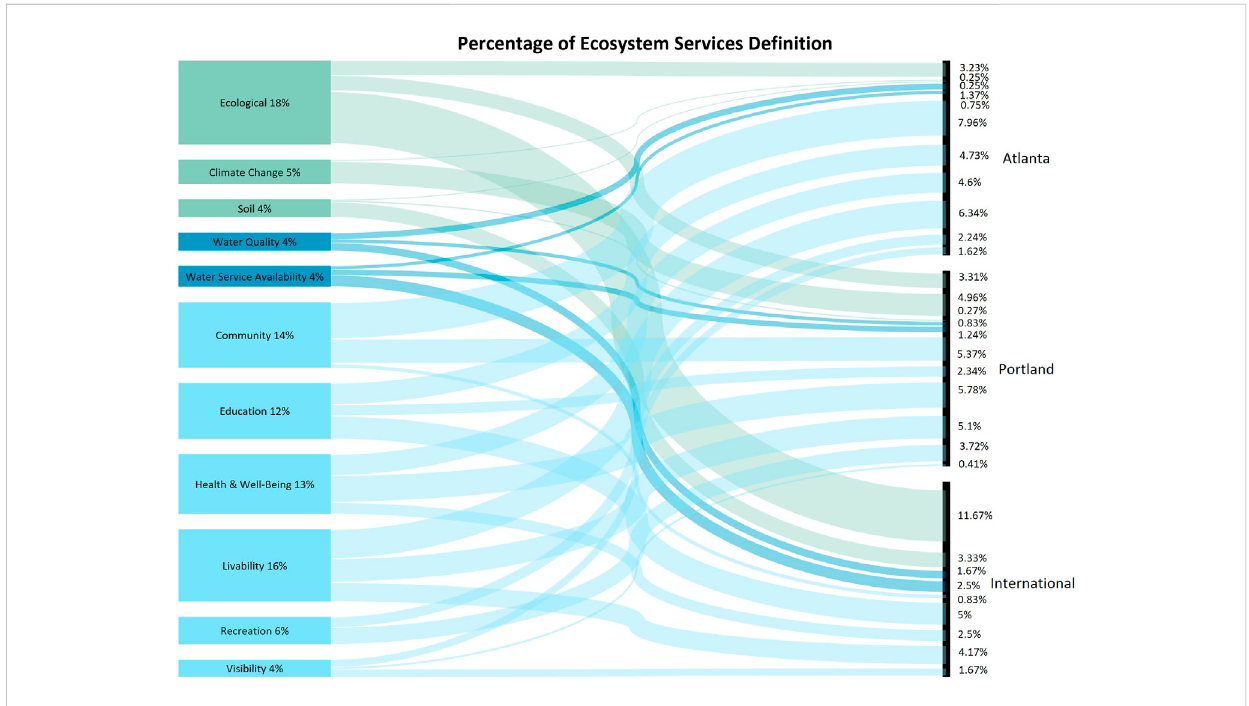
FIGURE 5 Example of visualization of the de fi nition of ecosystem